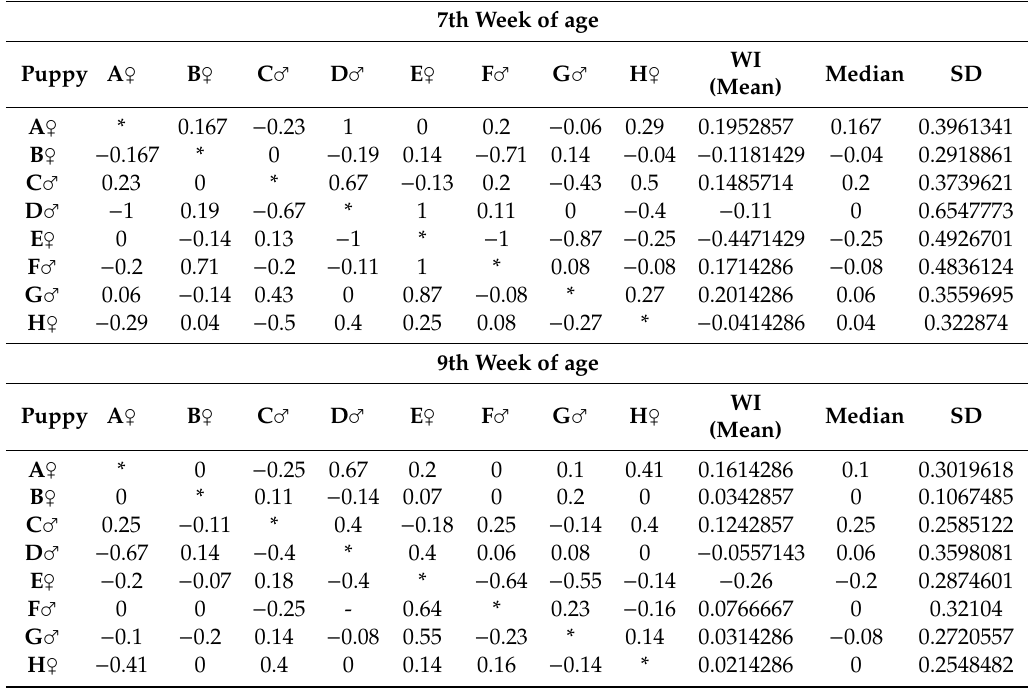
Table 5. Winning index calculated for each individual / each dyad (puppy pack 1). Winning index of 0 represents complete symmetry (each partner within dyad was in the position of a winner an equal amount of times).